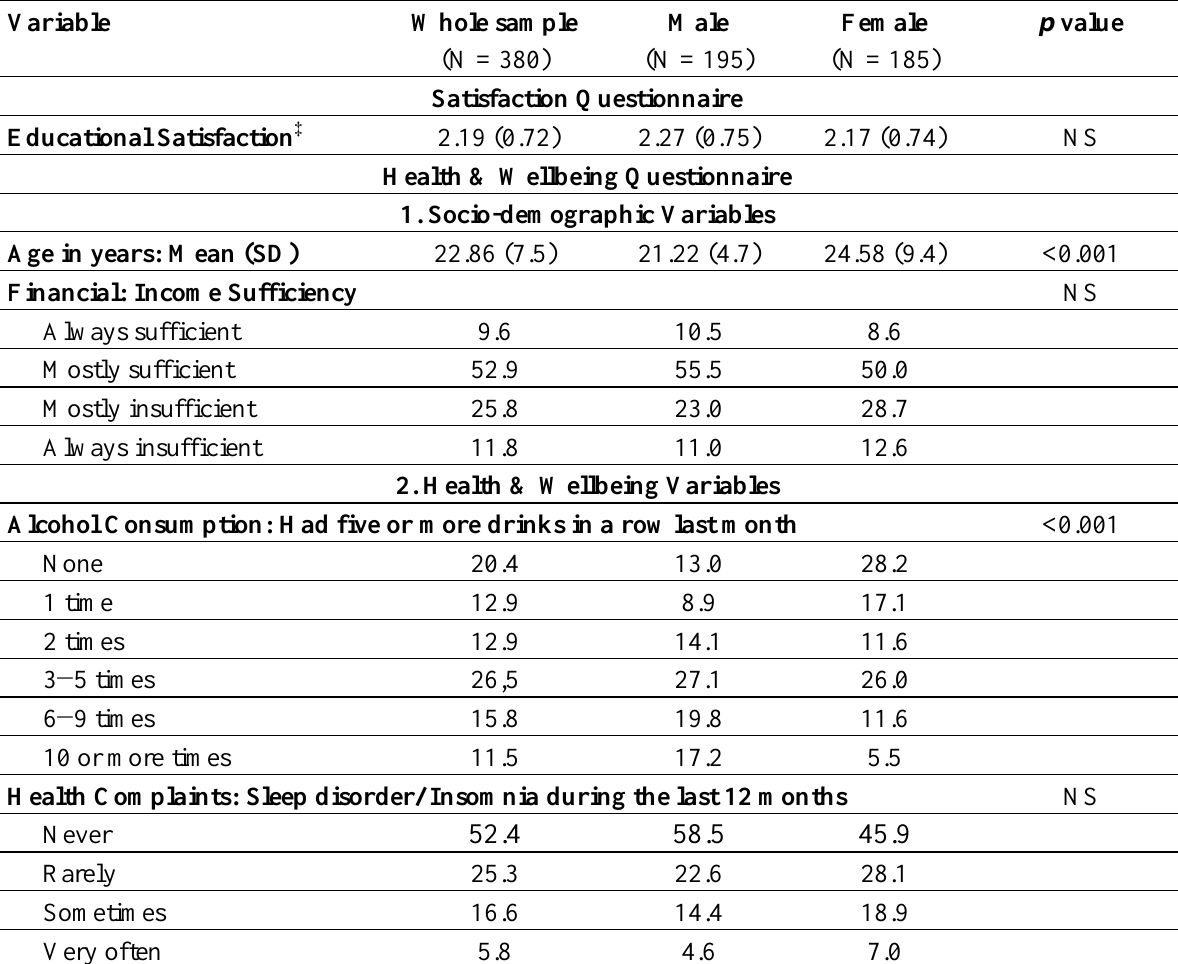
Table 1. Demographic and other selected characteristics of the study sample †